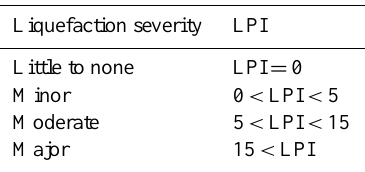
Table 2. Liquefaction severity as a function of liquefaction potential index, LPI (Iwasaki et al.,